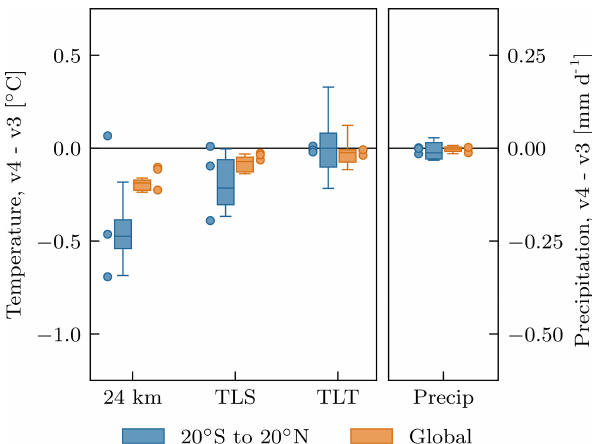
Figure 9. Difference in temperature and precipitation levels be- tween version 3 and version 4 for the 2 years following the Pinatubo eruption. Boxes show the interquartile range of the CanESM5 data from the 15-member ensemble, and whiskers mark the 10th and 90th percentiles. Individual markers show the values from each of the three EAMv1 ensemble